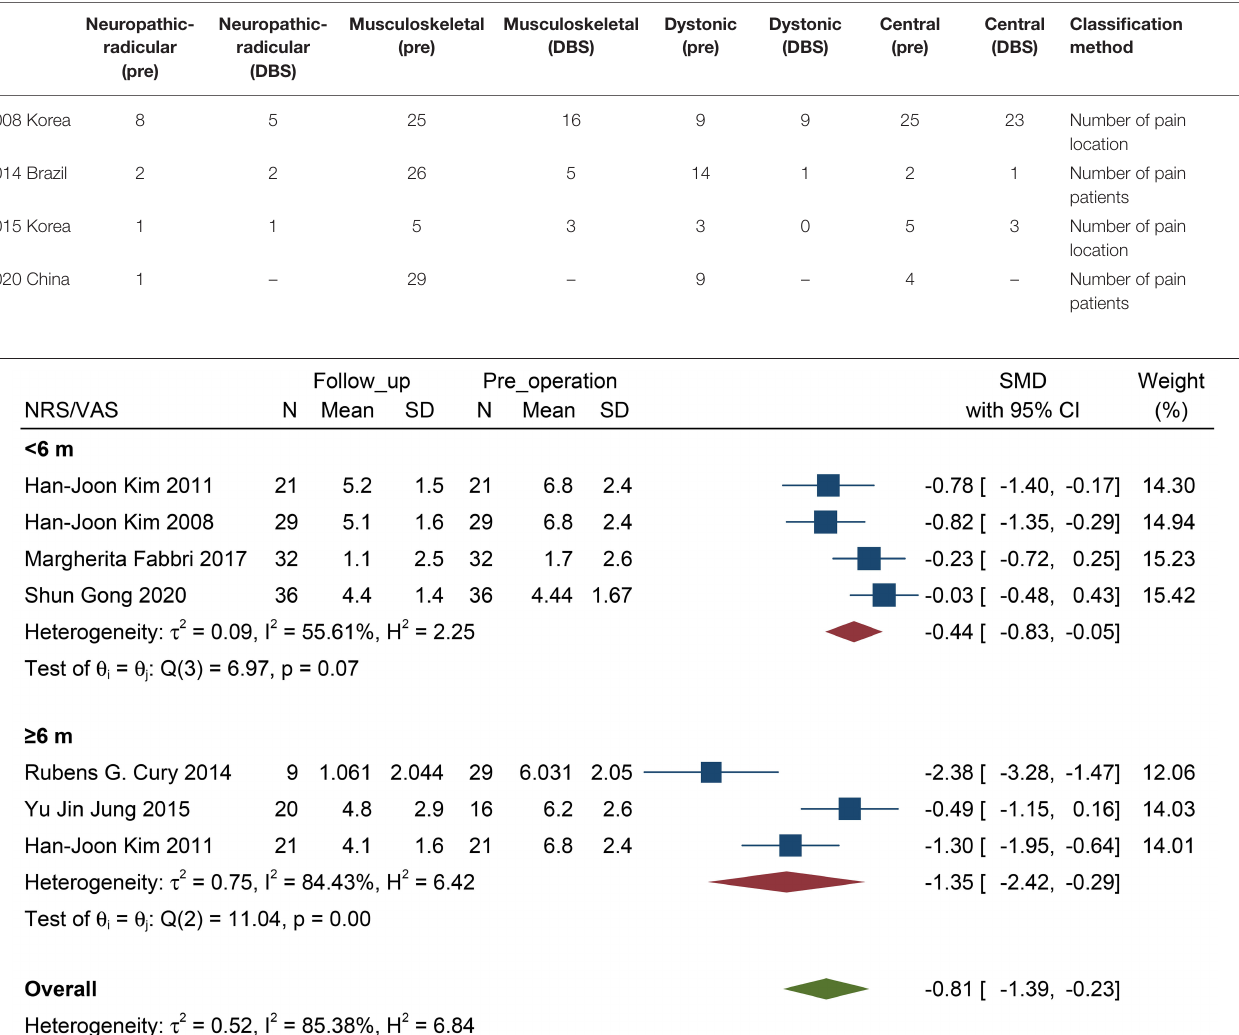
TABLE 3 | The number of pain (pre) means before surgery, and (DBS) means after STN-DBS. Neuropathic- radicular